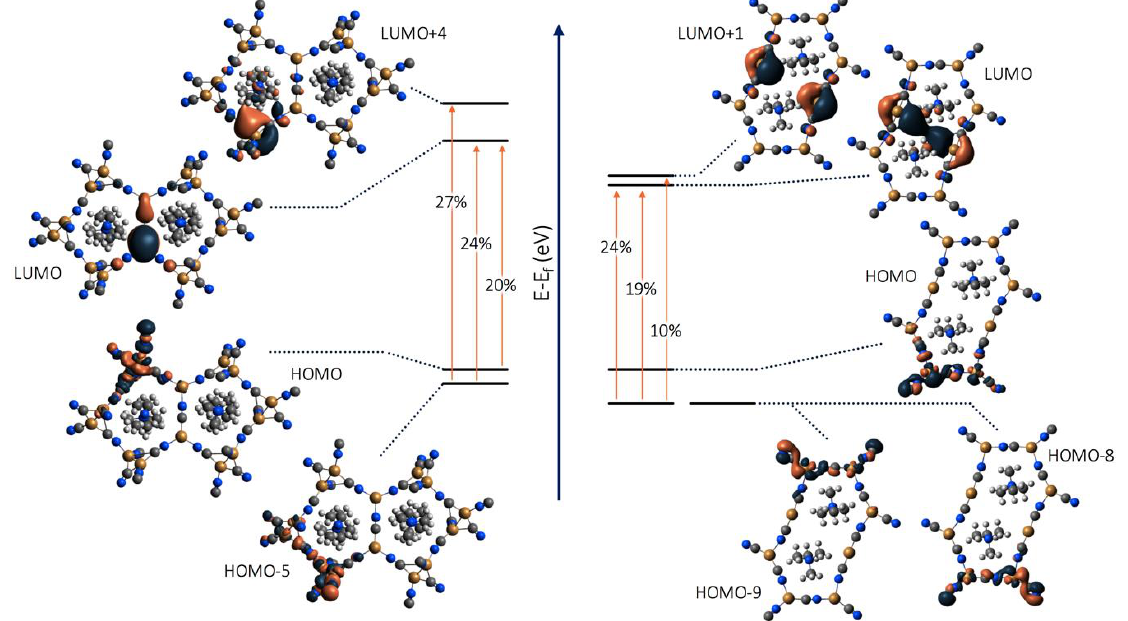
Figure 7. M06/CEP-31G(d) TD-DFT calculated isodensity representations of molecular orbital transitions ( ≥ 10% contribution) of ( left ) 1 and ( right ) 2 . Calculated at excited state energies for 1 = 300 nm and 2 = 330 nm. A complete list of negligible (<10% contribution) MO transitions can be found in the Supplementary